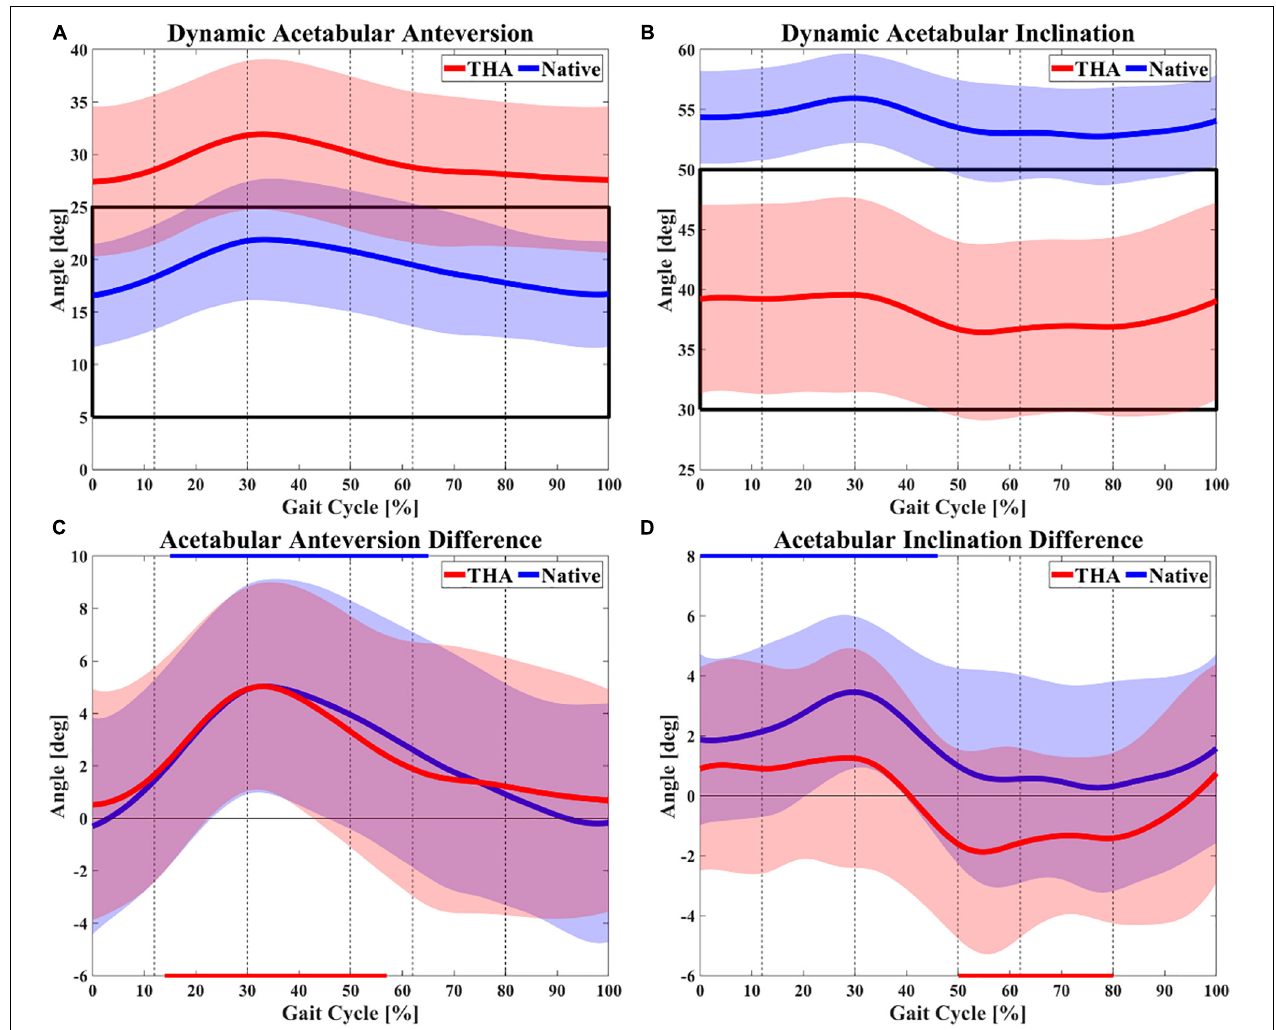
FIGURE 2 | Dynamic functional acetabular anteversion (A) and inclination (B) of both total hip arthroplasty (THA) and native hips during gait. The black box marks the Lewinnek safe zone of 15 ± 10 ◦ for anteversion and 40 ± 10 ◦ for inclination. Differences between dynamic functional (gait) and anatomical anteversion (C) as well as inclination (D) are also shown (walking angle–anatomical angle). The red and blue lines on the horizontal axes indicate whether there was significant difference between walking and anatomical angle for THA and native hips, respectively. The dotted lines divide gait cycle into loading response (0 ∼ 12%), midstance (12 ∼